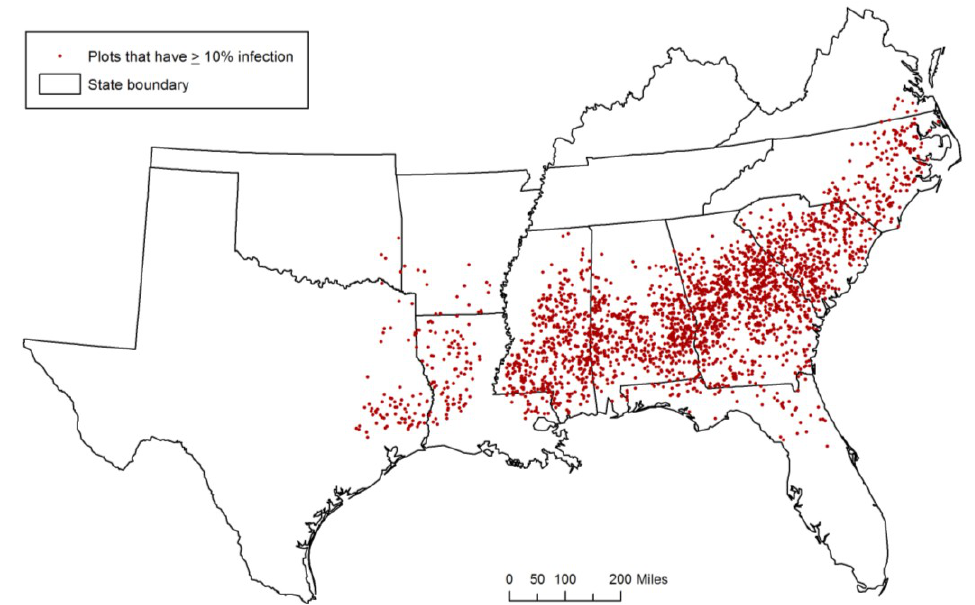
because total acreage of slash pine in North Carolina decreased by about 95,000 acres from 1990 to 2011 and by about 164,000 acres from 1993 to 2011 in South Carolina [15]. Figure 1. Location of Forest Inventory and Analysis (FIA) plots with the loblolly pine forest type and >10% fusiform rust infection on trees at least 5.0 inches diameter at breast height. Estimates of infection are based on FIA inventory year 2010 in Louisiana and 2011 in all other states. (Plot locations are approximate.)